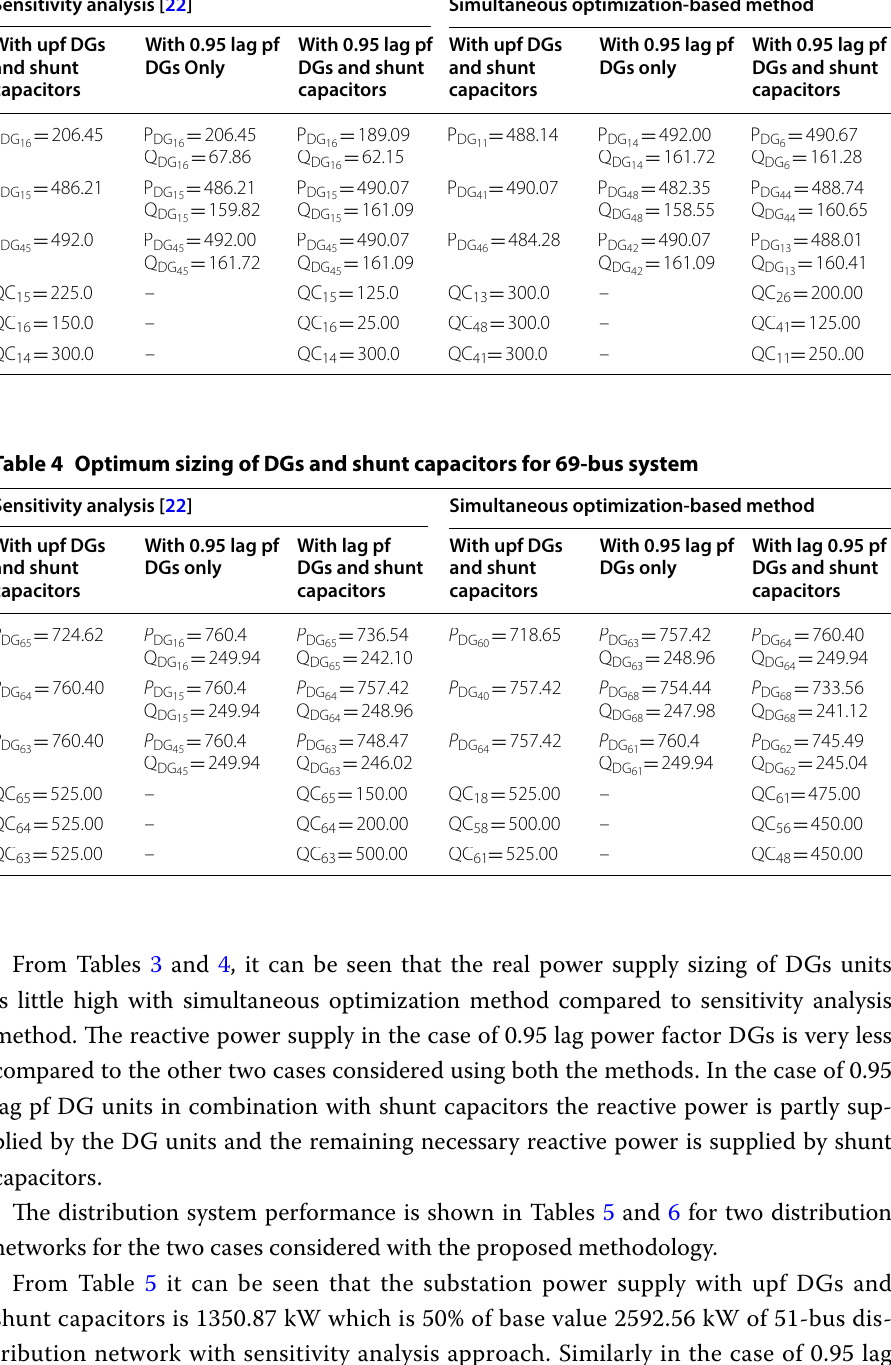
Table 3 Optimum sizing of DGs and shunt capacitors for 51-bus system Sensitivity analysis [22] Simultaneous optimization-based method With upf DGs With 0.95 lag pf With 0.95 lag pf With upf DGs and shunt DGs Only DGs and shunt and shunt capacitors capacitors